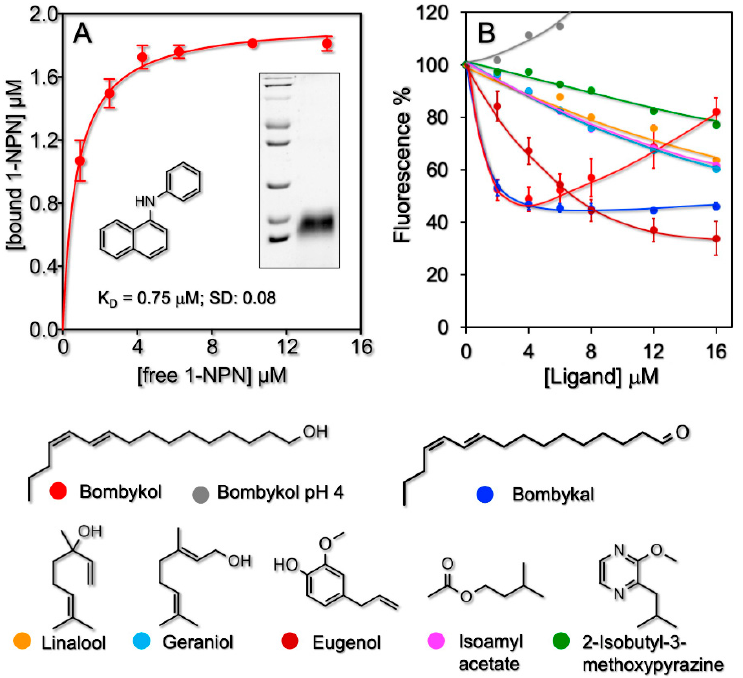
Figure 1. Binding activity of B. mori pheromone-binding protein (PBP)1 measured in solution along with the fluorescent assay. ( A ) The protein binds, with good affinity (0.75 μ M), the fluorescent probe N-phenyl-1-naphthylamine (1-NPN), whose structure is shown. The inset reports the electrophoretic analysis (SDS-PAGE) of a sample of the recombinant protein used in all experiments. ( B ) Displacement of the fluorescent probe 1-NPN by different chemicals. The protein and the probe, both at the concentration of 2 µ M, were titrated with increasing amounts of each competitor. Bombykol and bombykal are the strongest ligand. Of the other compounds tested, only eugenol exhibited appreciable affinity. Interestingly, the affinity of bombykol is completely abolished at pH 4 due to a major conformational change of the protein [32]. The increasing behavior of the bombykol displacement curve at concentrations higher than 3–4 µ M is due to micelles formation